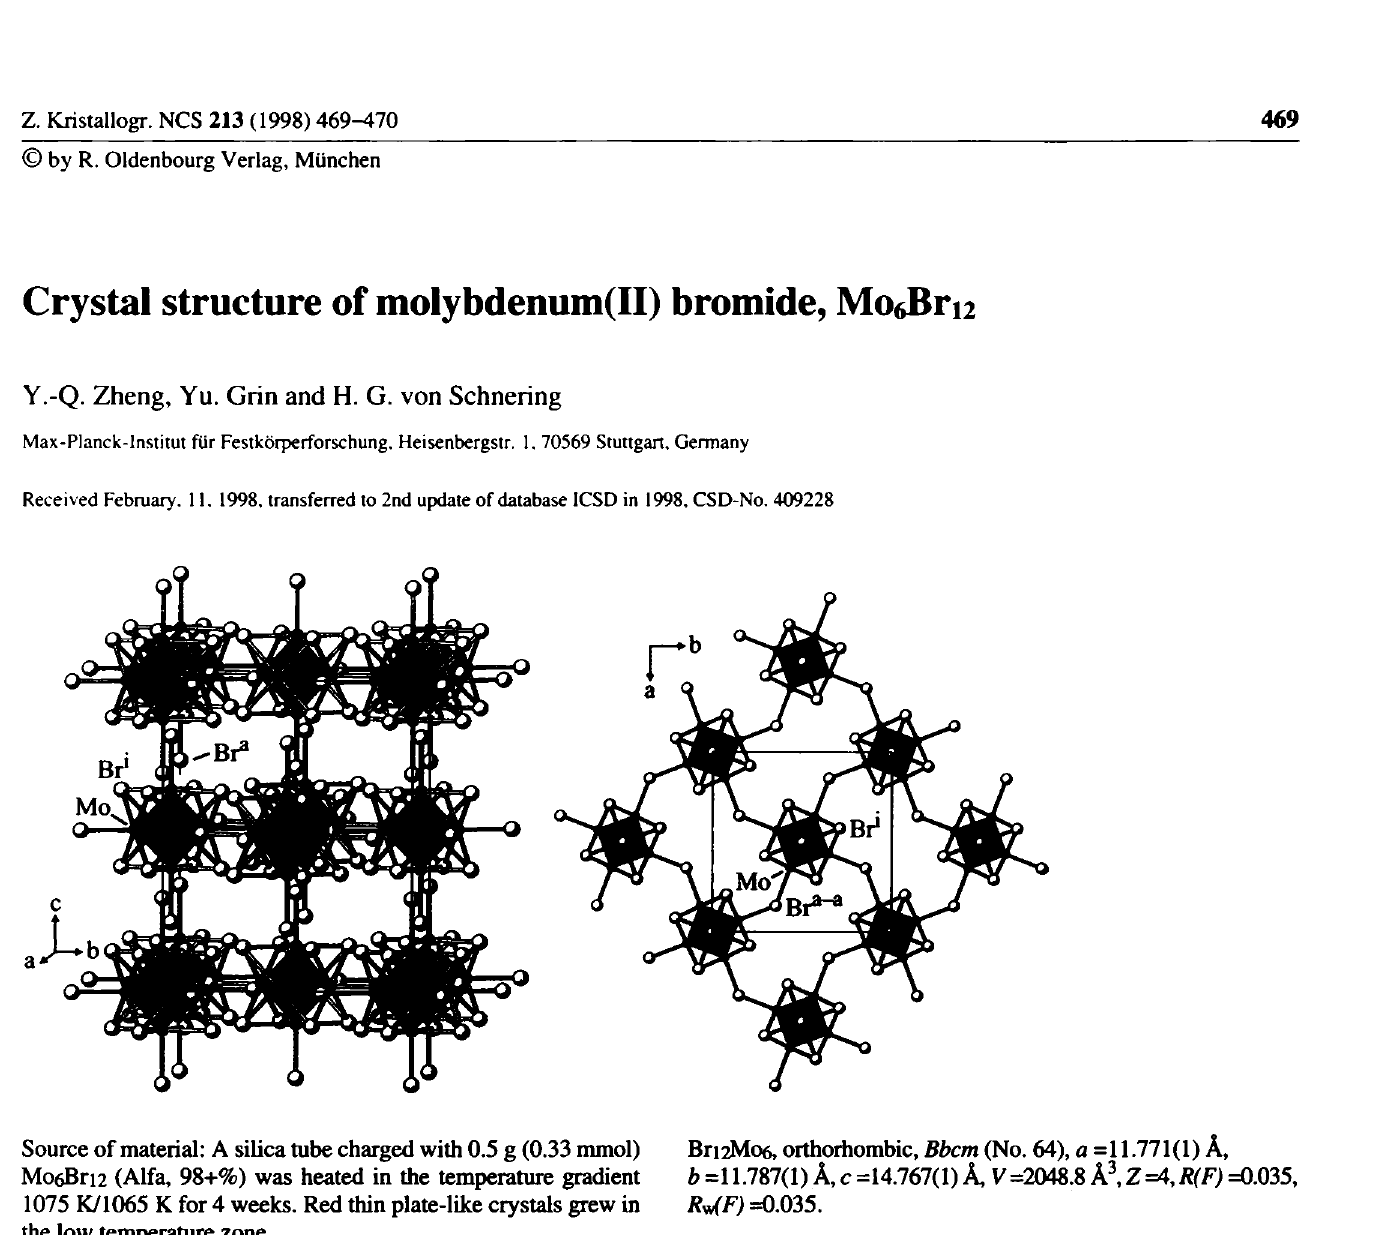
Table 1. Parameters used for the X-ray data collection